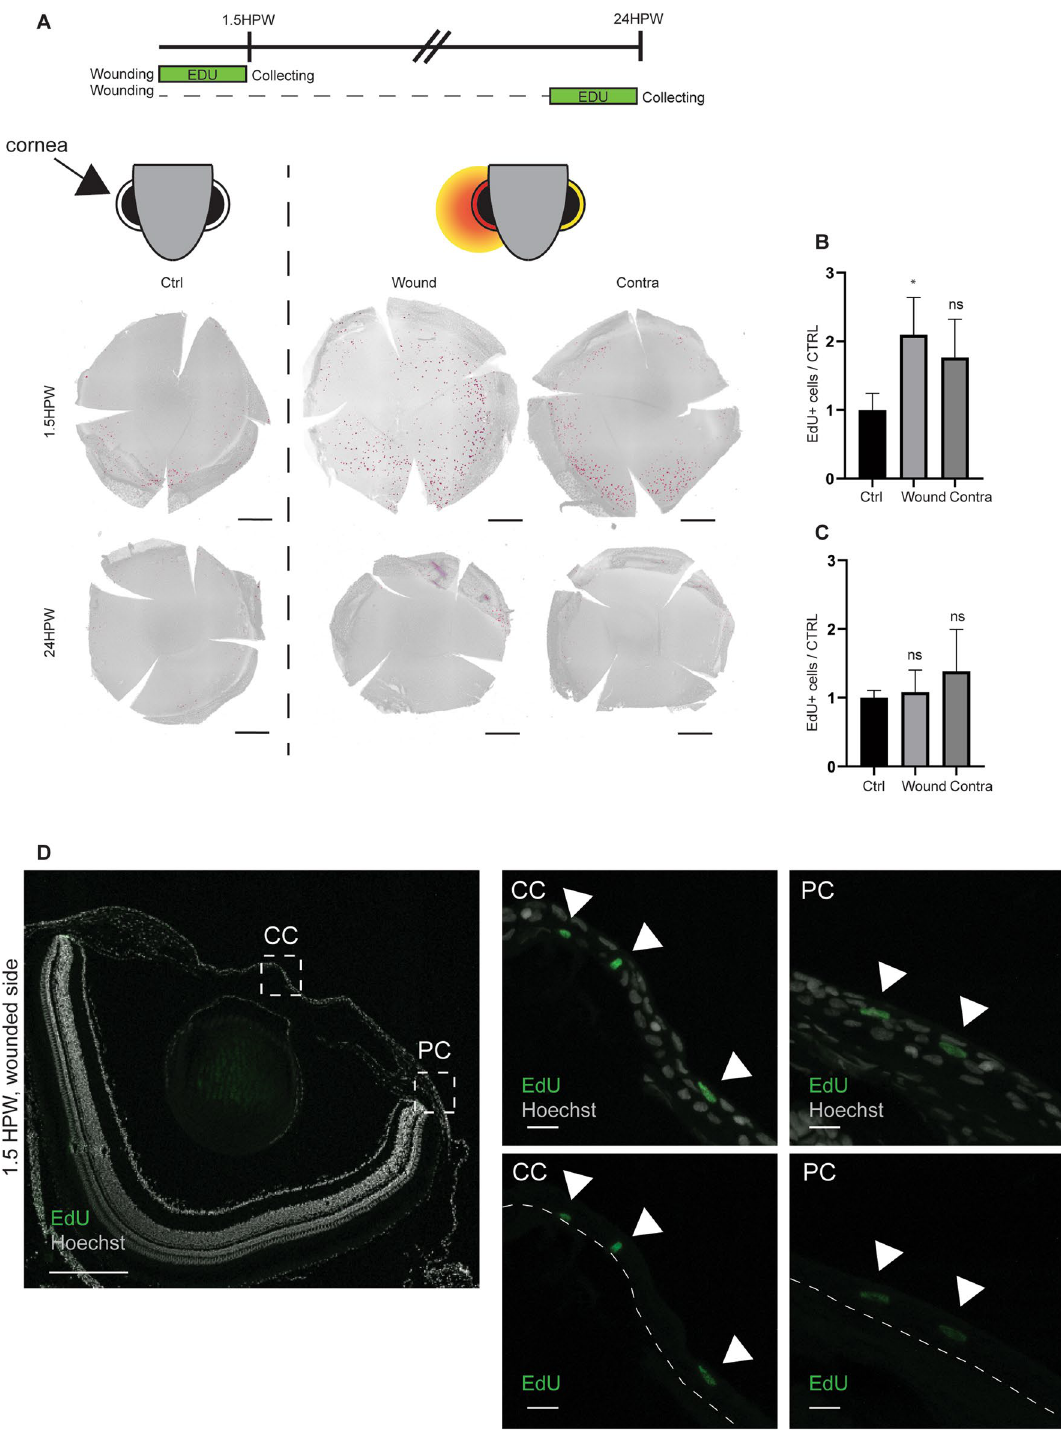
Figure 2. Induction of cell proliferation after epithelial abrasion. ( A ) EdU incorporation is performed 1.5 h prior to sample collection, which happens 1.5 or 24HPW. The EdU labelling on whole cornea on wounded side and contralateral side shows proliferating cells mainly in the periphery. ( B , C ) The quantification of EdU-positive cells at 1.5HPW ( B ), or at 24HPW ( C ), demonstrates a transitory increase of cell proliferation at 1.5HPW on the wounded side. n = 3 per group. ( D ) EdU signal with nuclear counterstaining on formalin-fixed, paraffin- embedded section (5 µm) shows the presence of EdU+ cells in all epithelial layers. Left: Overview of an EdU- labeled, wounded cornea at 1.5HPW. Right: Close-ups of the areas indicated with dashed line on central (CC) and peripheral (PC) cornea. Upper row: EdU+ cells (green, arrowheads) with Hoechst-staining, lower row: Edu+ cells only. Quantification data represent mean + stdev, *P < 0.05, Kruskal–Wallis test followed by Dunn’s test for multiple comparisons. Scale bars: 300 µm in A, 200 and 10 µm in D. HPW: hours